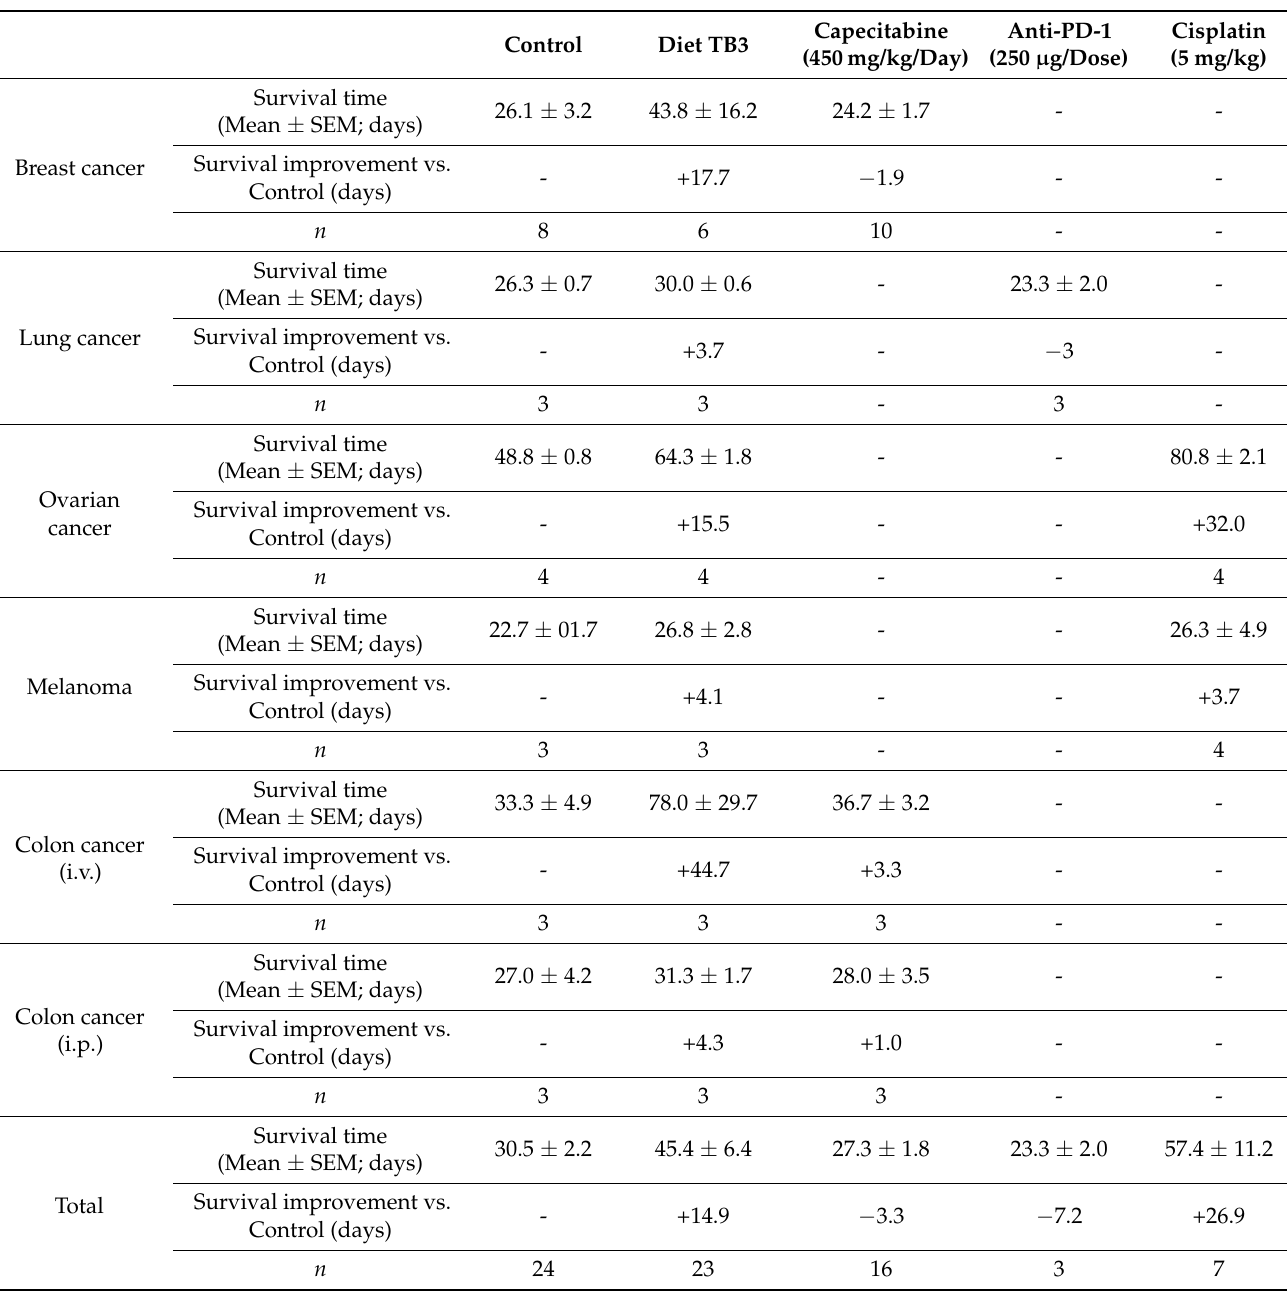
Table 5. Survival of mice with different type of cancer treated with diet TB3, capecitabine, anti-PD-1 or